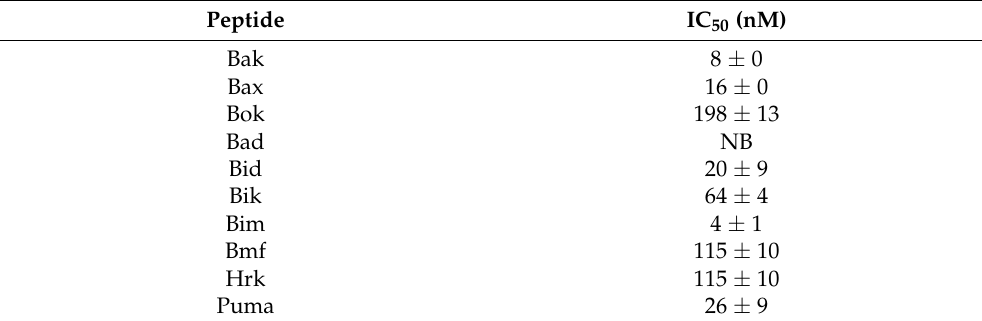
Table 1. Binding affinities determined by Surface Plasmon Resonance of recombinant KsBcl-2 homolog KsBcl-2 with pro-apoptotic BH3 motif.